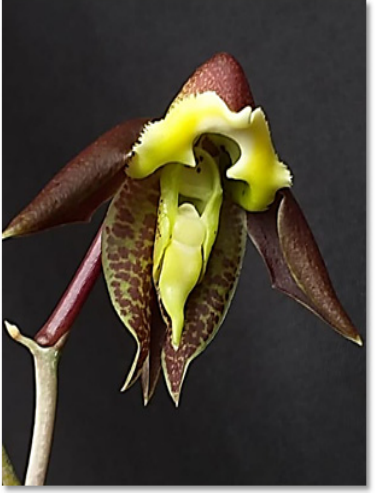
Figure 11. Catasetum gnomus (Source Luiz Otavio Adão)